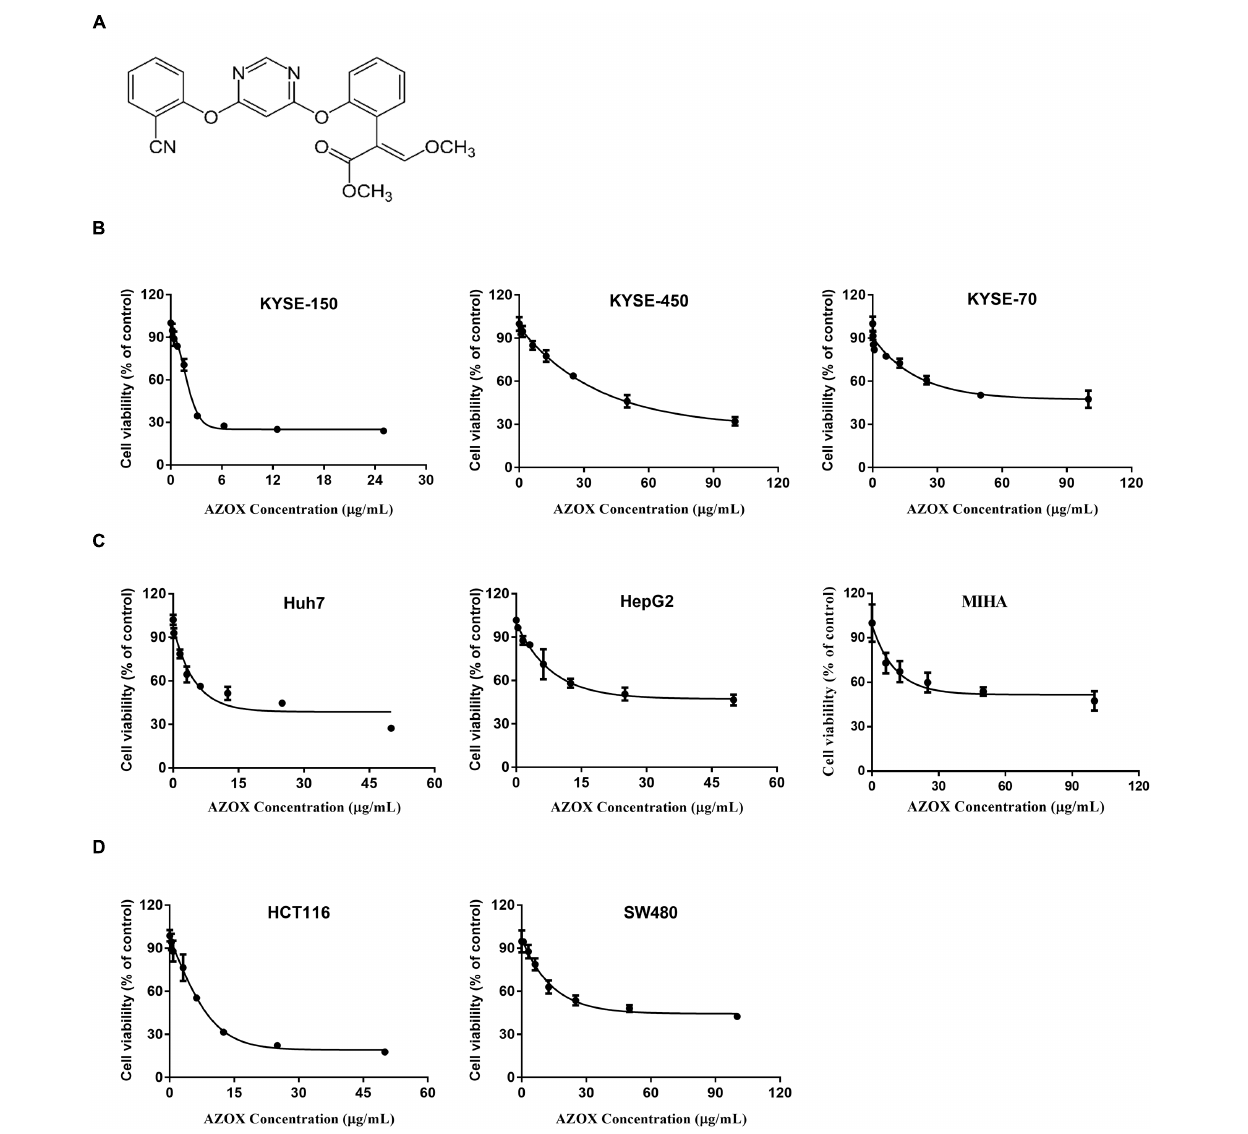
FIGURE 1 | AZOX decreased the viability of cancer cells. (A) Chemical structure of AZOX. (B) MTT assay of esophageal cancer cell lines (KYSE-150, KYSE-450, and KYSE-70) treated with increasing concentration of AZOX for 48 h. (C) MTT assay of liver cancer cell lines (Huh-7 and HepG2) and non-tumorigenic normal human hepatocyte cell line (MIHA) treated with increasing concentration of AZOX for 48 h. (D) MTT assay of colon cancer cell lines (HCT116 and SW480) treated with increasing concentration of AZOX for 48 h. The IC 50 values were calculated using GraphPad Prism 6.0 software.